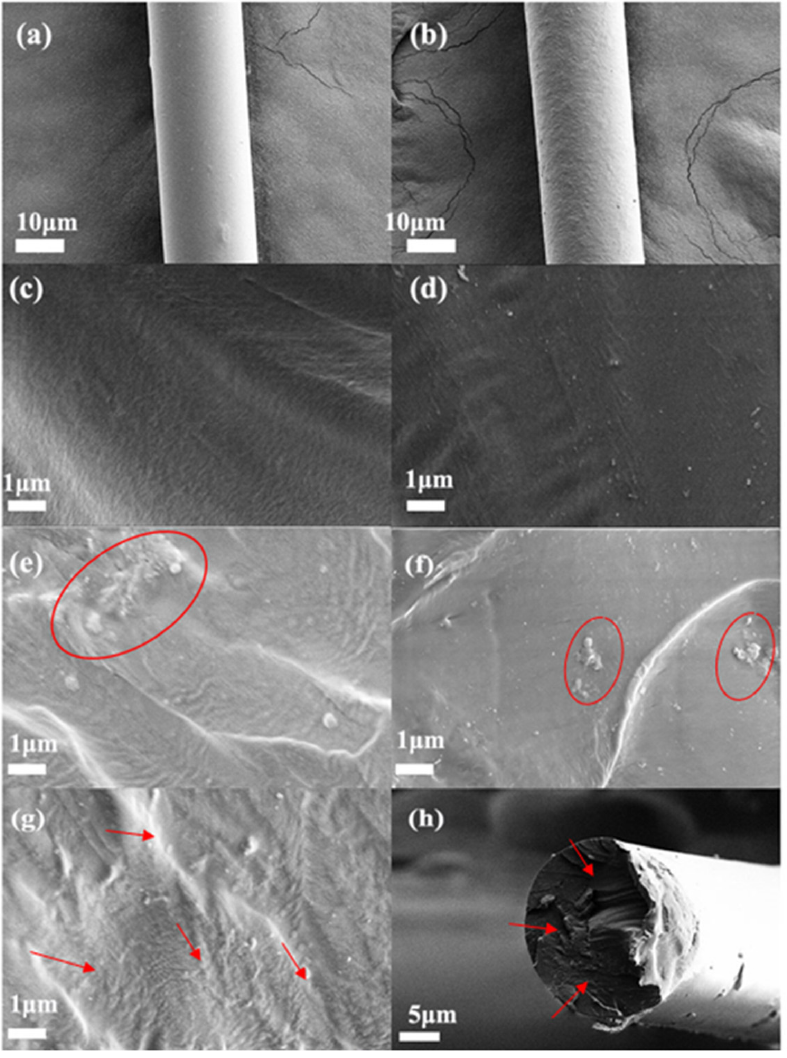
Figure 7. SEM images: the surface morphologies of PA6 fiber ( a ) and 0.15 wt% PDA-rGO/PA6 composite fiber ( b ); the cross-section morphologies of the fibers: PA6 ( c ), 0.05 wt% PDA-rGO/PA6 ( d ), 0.3 wt% PDA-rGO/PA6 ( e ), 0.15 wt%rGO/PA6 ( f ), and 0.15 wt% PDA-rGO/PA6 ( g , h ).